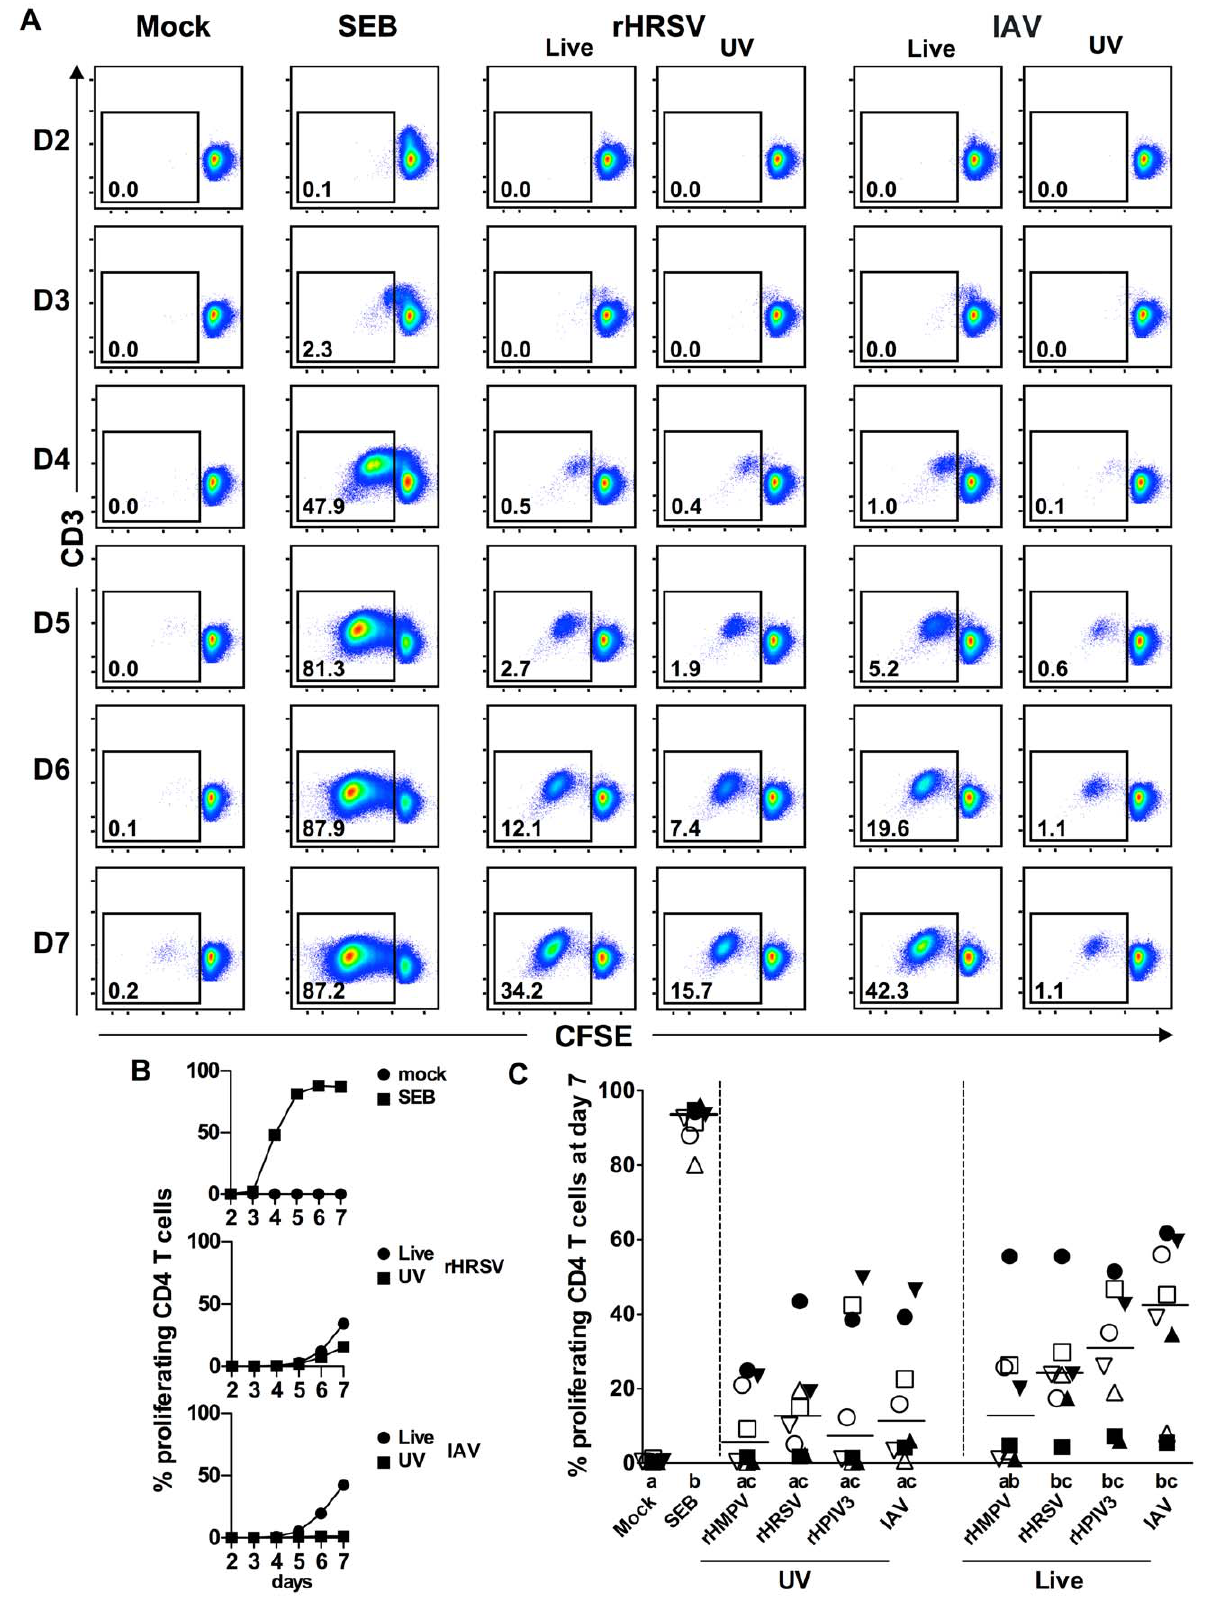
Figure 2. Proliferation of CD4 + T cells in response to autologous MDDC after exposure to SEB or purified virus. (A) Time course of CD4 + T cell proliferation in response to MDDC that were mock-treated or treated with SEB, rHRSV, or IAV, using cells from a single donor. Days of co- culture are indicated to the left. Proliferated cells are boxed, and their percentage relative to the total live population is indicated. (B) Line graphs of PLoS ONE |